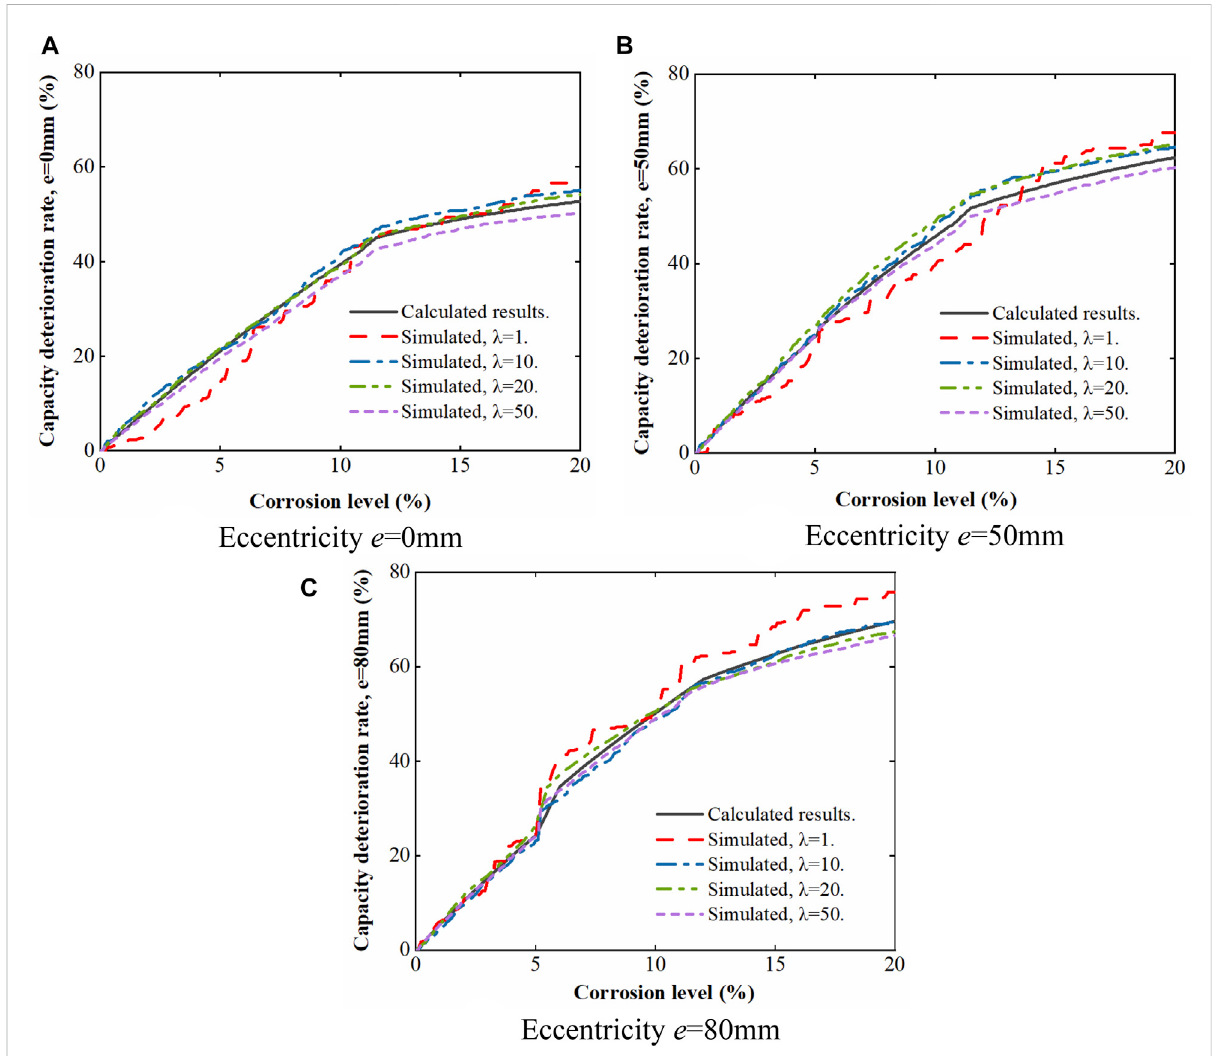
FIGURE 11 Simulatedbearingcapacitydeteriorationrategrowthbygammasequencesampling(GSS)withvariousvaluesofscaleparameter λ anddifferent